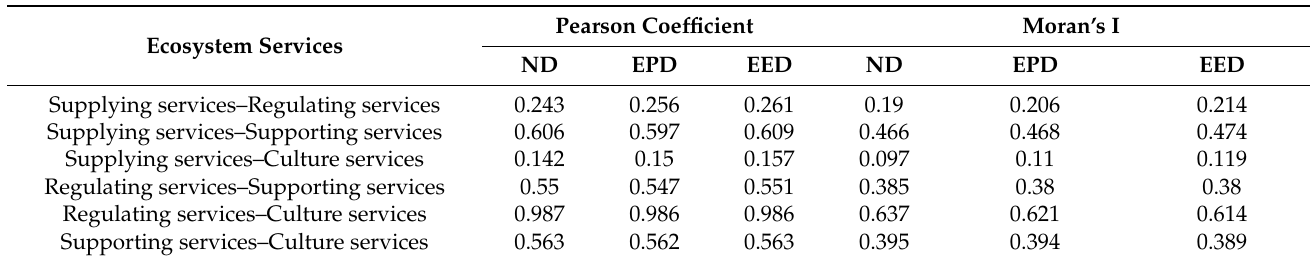
Table 4. Correlation analysis results for the four ecosystem services under different scenarios in the Manas River Basin in